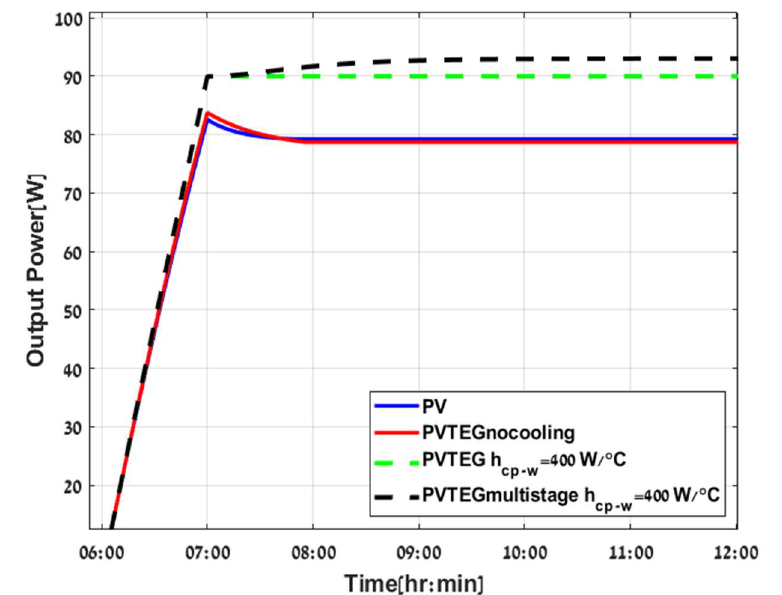
Figure 11. Configuration of PV stand-alone (blue, continuous line), PVTEG without cooling (red, continuous line), PVTEG (green dashed line), and PV Multistage TEG (black dashed line).